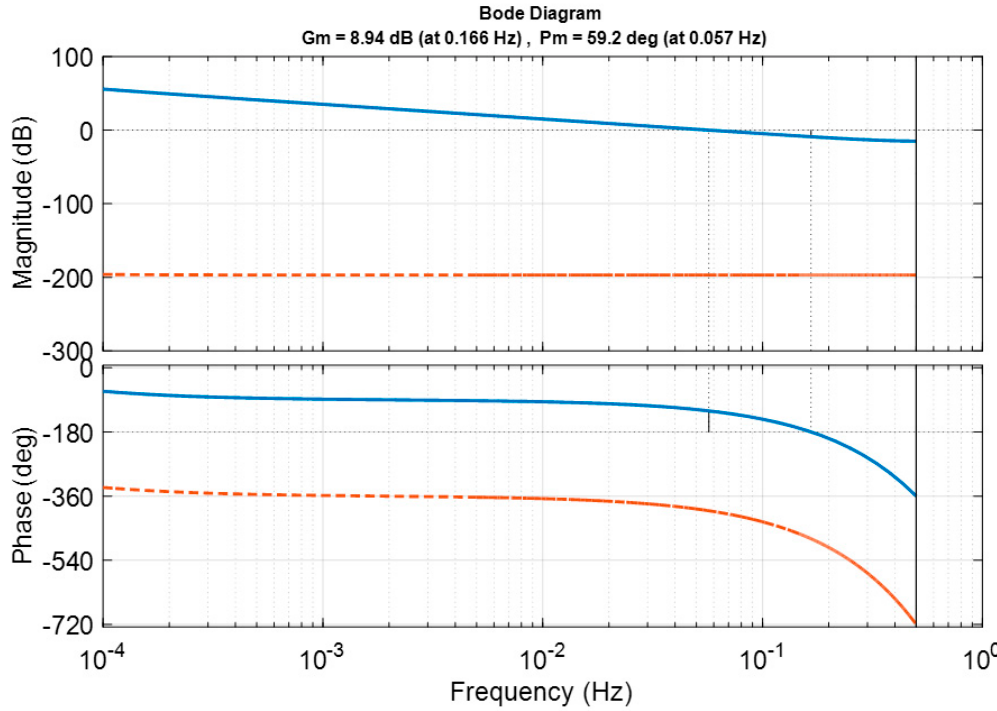
Figure 7. The bode plot of uncompensated (red-dashed curve) and compensated (blue-solid curve) SOC balancing control loop.